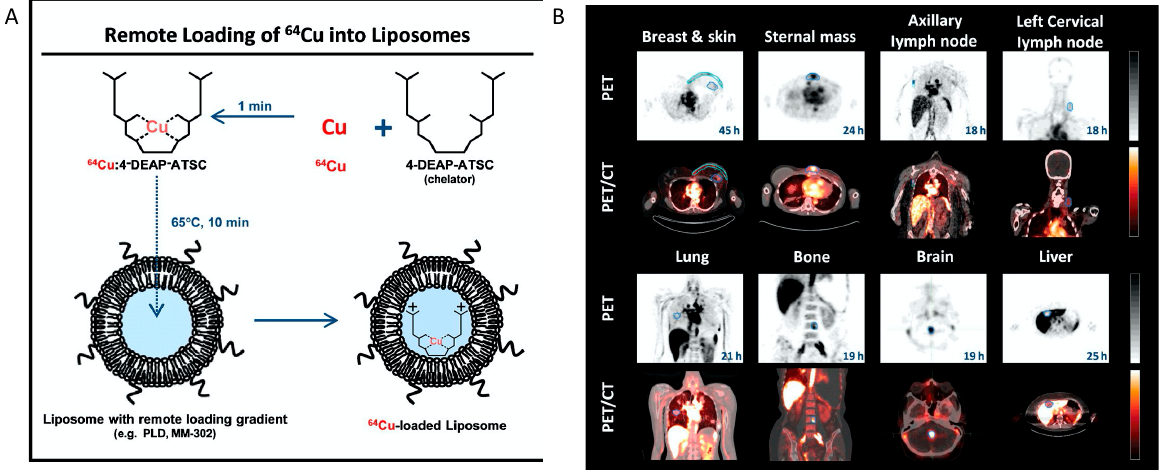
Figure 2. The construction 64 Cu-MM-302 and its application in lesion detection in the phase I clinical trial (NCT01304797). ( A ) Schematic depicting remote loading of 64 Cu into liposomes using the novel gradient-loadable chelator 4-DEAP-ATSC. Heating liposomes above the lipid bilayer phase transition temperature facilitates transmembrane transport of unprotonated 4-DEAP-ATSC, which becomes protonated within the liposome and remains entrapped. ( B ) Representative PET and fused PET/CT images of 64 Cu-MM-302 in lesions at different anatomic locations. Intensity scale bars represent deposition from 0 to 10%ID/kg (derived from SUVmedian). The regions of interest used to measure tumor deposition of 64 Cu-MM-302 are shown in blue or turquoise outlines. 64 Cu-MM-302 uptake was detected at above muscle background level in lesions of various anatomic locations that are common for HER2-positive metastatic diseases. Figures are adapted based on Refs. [95,101] with permissions. Copyright 2017 American Association for Cancer Research.